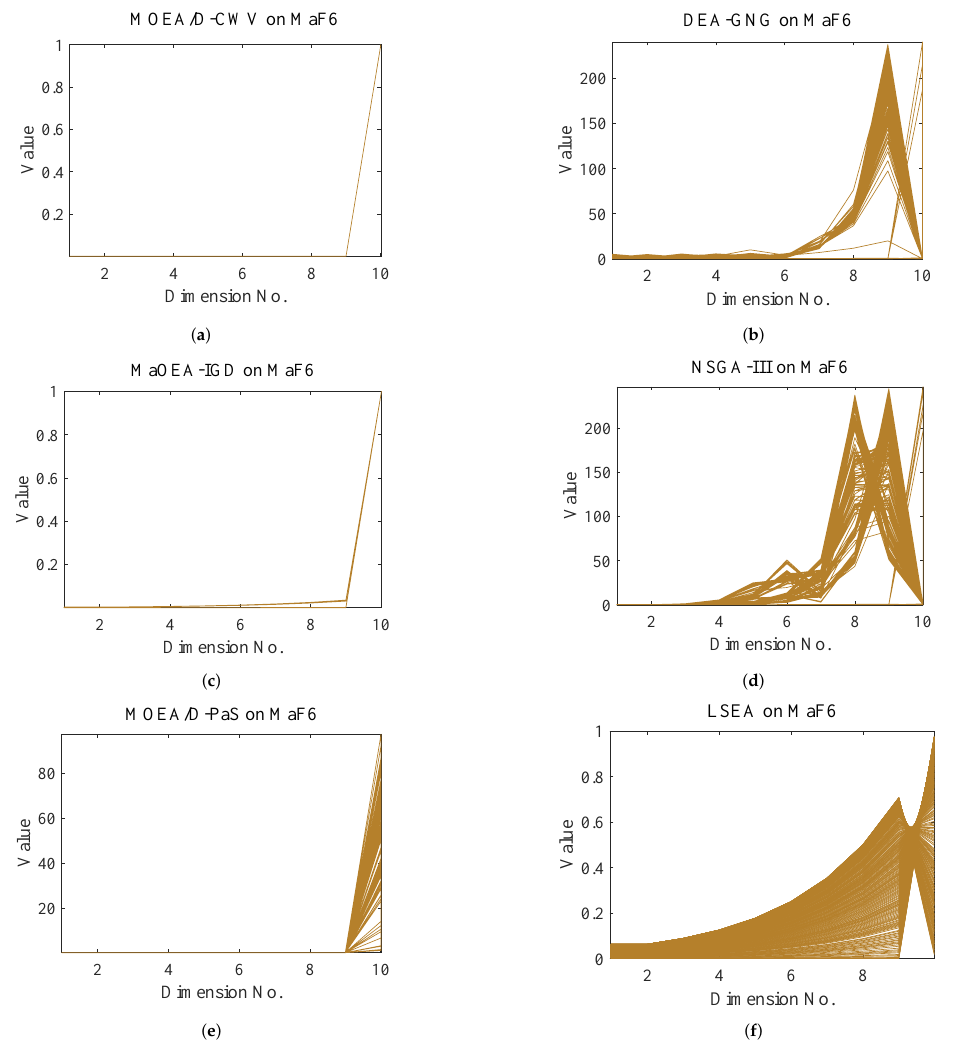
Figure 3. Distributions of populations obtained by the six algorithms on 10-objective MaF6. ( a ) out- put population of MaOEA-IGD, ( b ) output population of DEA-GNG, ( c ) output population of MaOEA-IGD, ( d ) output population of NSGA-III, ( e ) output population of MOEA/D-PaS, ( f ) output population of